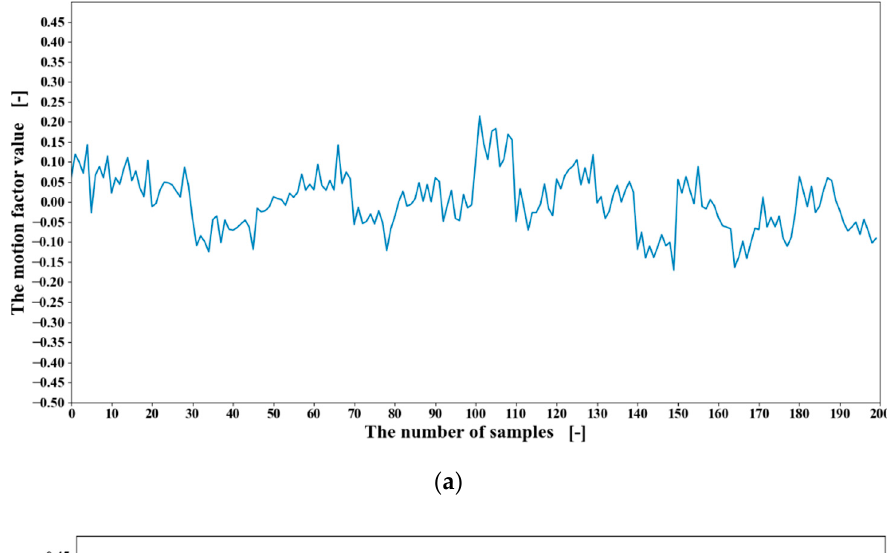
Figure 14. The RMS feature values of 20 motions from different participants:( a ) participant four; ( b ) participant five.